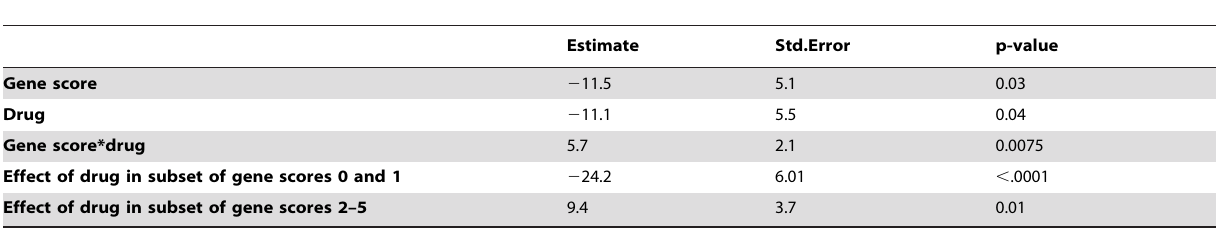
Table 3. Results of the mixed-effects model in relation to skilled motor learning.